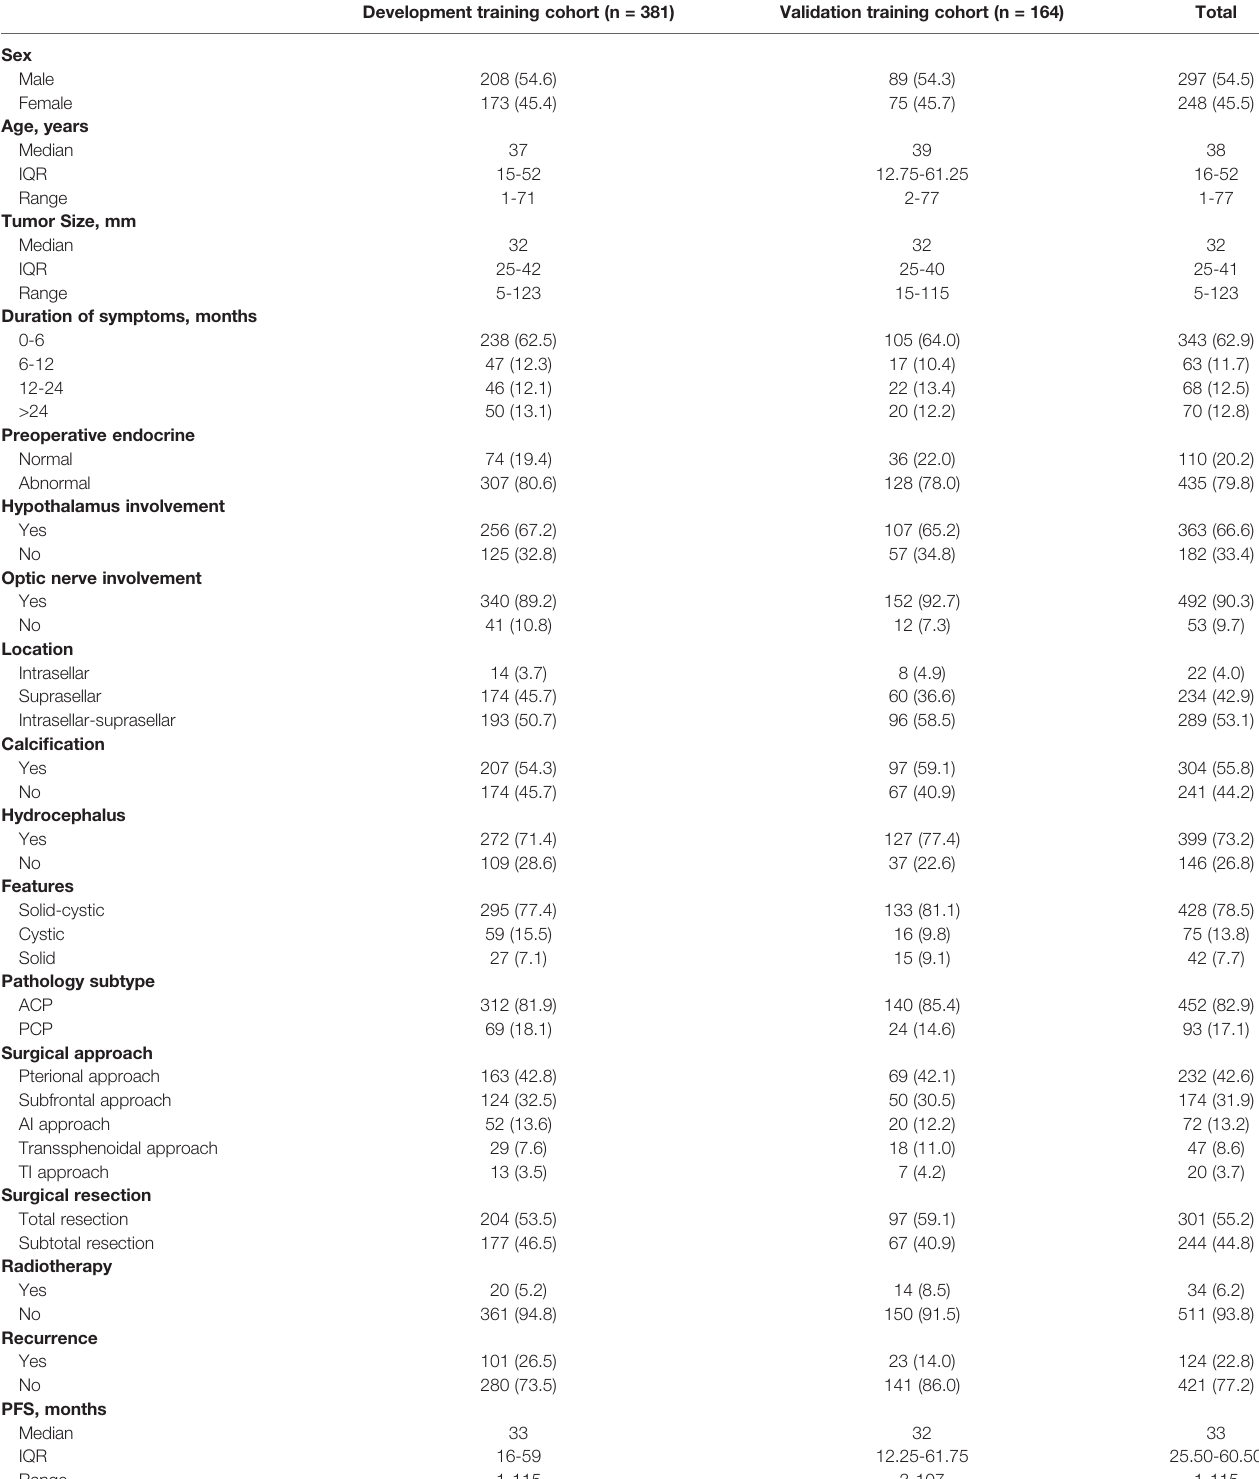
TABLE 1 | Baseline characteristics of patients in the development and validation